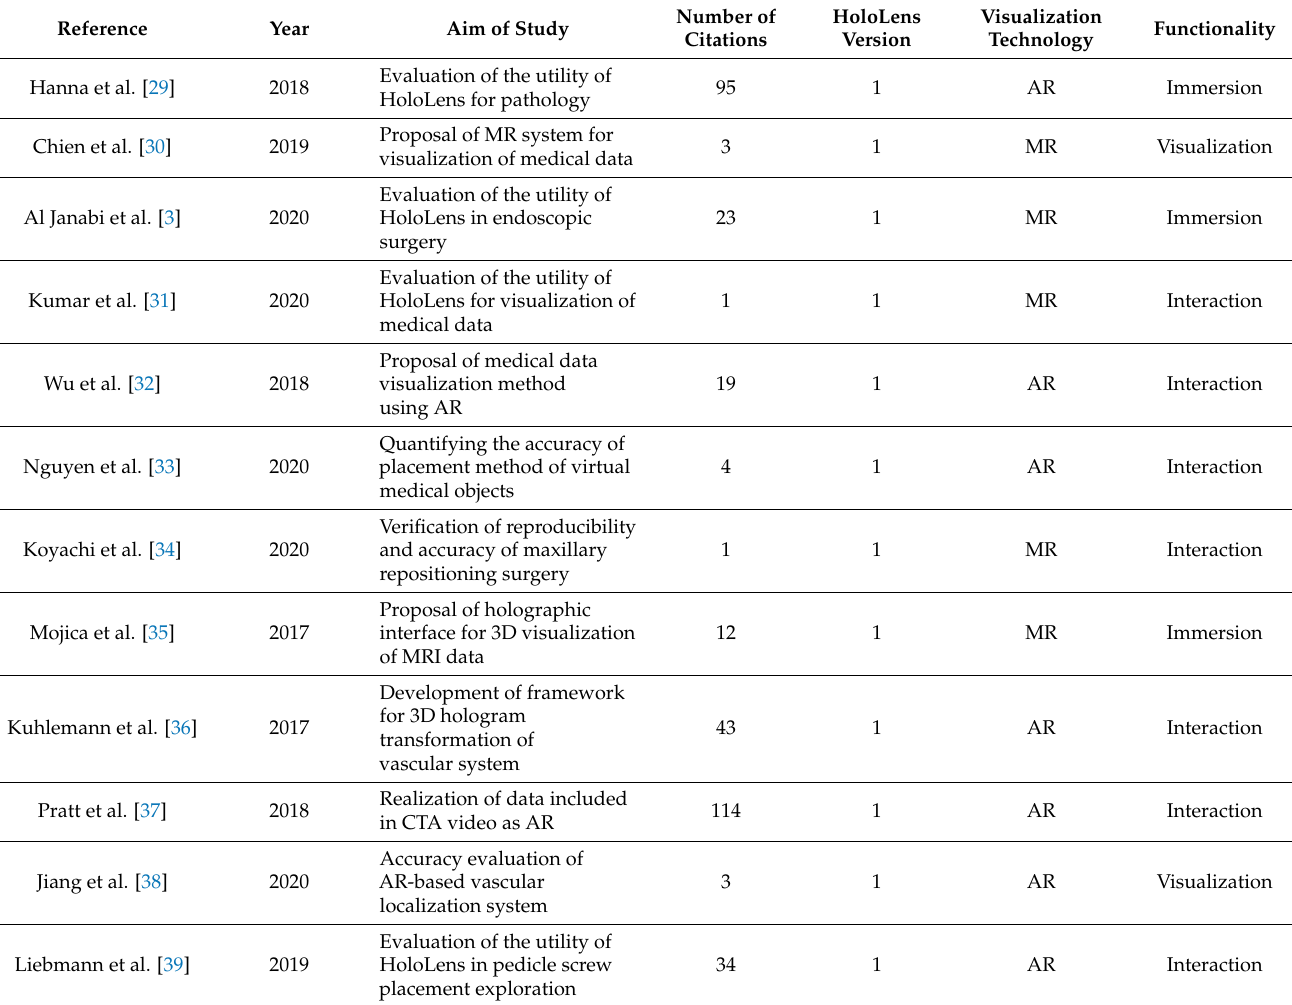
Table 2. Summary of Microsoft HoloLens application for medical auxiliary devices and